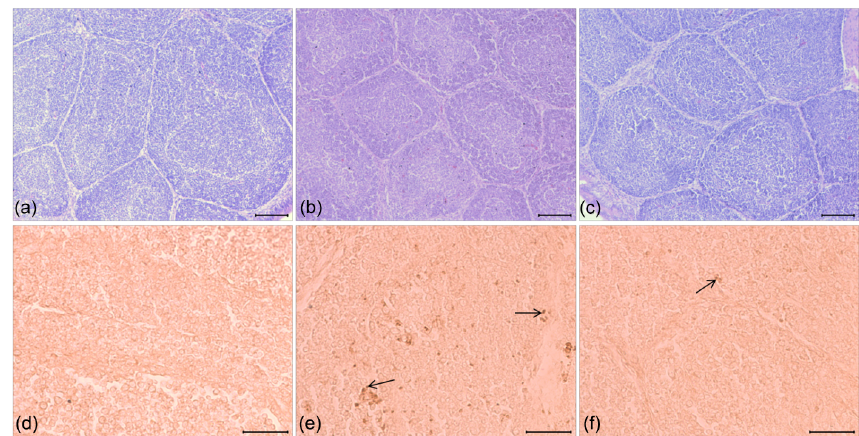
Figure 1. Effects of GABA on the tissue structure and cell apoptosis of the BF in 4-week-old chicks under heat stress. (a–c) The BF tissue structure of chicks, bar = 100µm. (d–f) Cell apoptosis in the BF of chicks, bar = 50µm. (a, d) Control group; (b, e) HS group; (c, f) GABA + HS group. Arrows: apoptotic